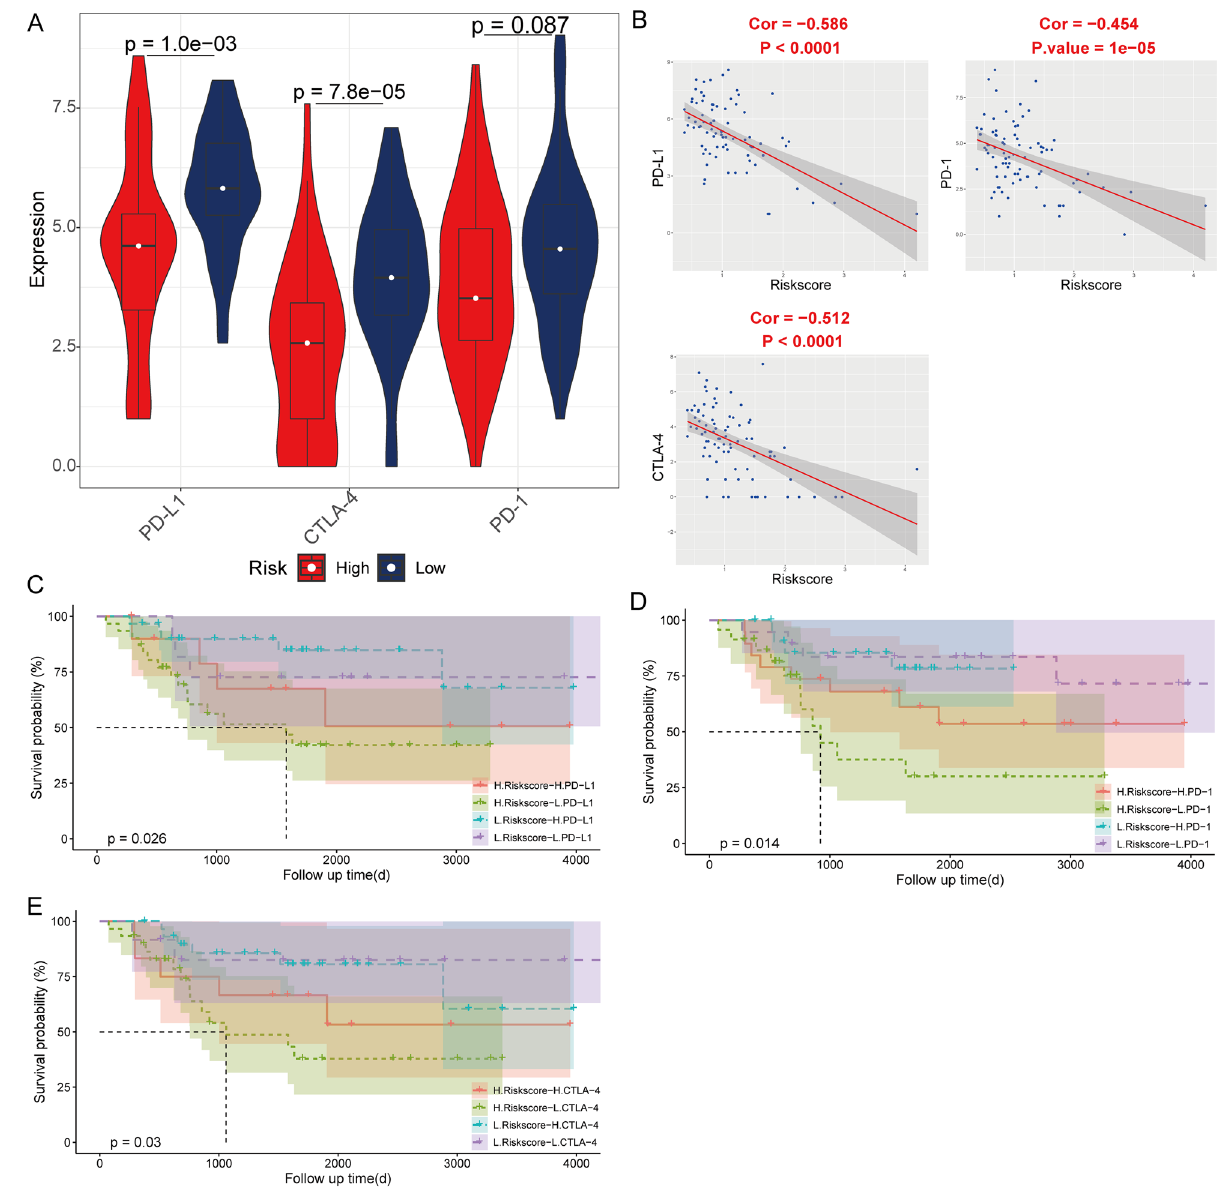
Figure 7. The correlation of risk score with immune checkpoints in the TCGA cohort. ( A ) Comparison of expression of immune checkpoints between high- and low-risk score group ( B ) The correlation between the risk score and expression of immune checkpoints. Kaplan–Meier analysis of the four groups based on the risk score and the expression of PD-L1 ( C ), PD-1 ( D ) and CTLA-4 ( E